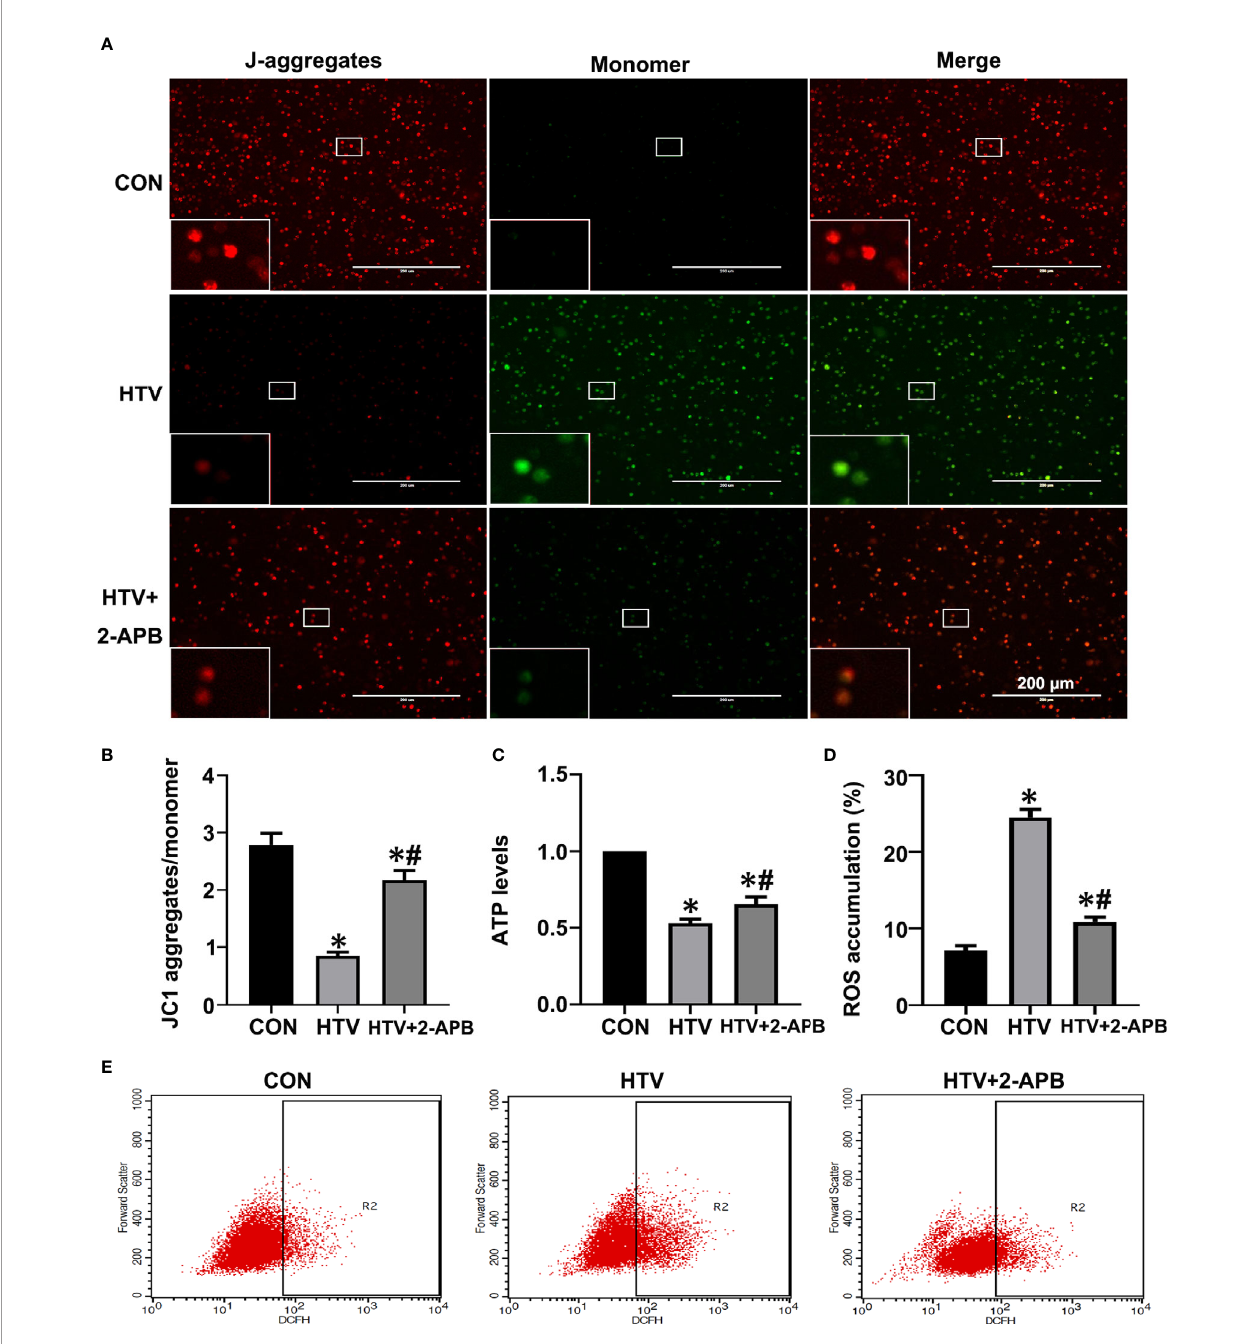
FIGURE 7 | 2-APB improves mitochondrial dysfunction in HTV-treated mice. (A, B) Fluorescence microscopy and the ratio of JC-1 staining (red, J-aggregates; green, monomer) in lung tissues from CON, HTV and HTV+2-APB group, Scale bar: 200 m m. An inset picture was employed to show the indicated area at 4X magni fi cation. (C) Levels of ATP. (D, E) Levels of ROS were determined by fl ow cytometry. Data are expressed as means ± SD (n = 6 per group). * P < 0.05 vs . CON group. # P < 0.05 vs . HTV